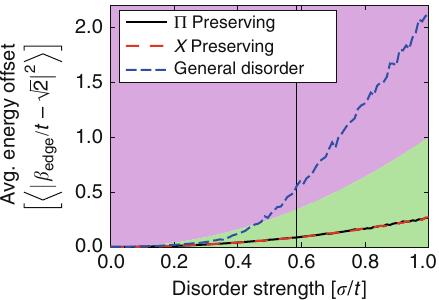
= t (cid:2) ffiffiffi Fig. 2 Disorder analysis. The averaged mean squared difference hj β edge p 2 j 2 i between the boundary state energy β edge in the presence of disorder ffiffiffi p t , as a function of the 2 and the energy of the undisturbed system β 0 ¼ disorder strength σ . Three different disorder types are used, which either do not break one of the symmetries ( χ or Π ) or break both. All three disorder types are chosen such that on average both symmetries, χ and Π , are preserved, i.e., the disorder distribution has a vanishing mean. The vertical solid line indicates the size of the gap between the boundary state and the nearest bulk band. The red and green regions de fi ne an energy offset that is bigger (red) or smaller (green) than ( σ ∕ t ) 2 , which corresponds to the energy scale of the disorder. The disorder-averaging simulations were run using a lattice with 99 sites and every disorder strength σ was realized 10,000 times. Fig. 3 Experimental implementation. a Light dynamics in the three level system of two waveguides and an auxiliary waveguide with carefully chosen refractive index. Since most of the amplitude is in the original waveguides, we can trace out the dynamics of the auxiliary waveguide and obtain a two- level system with an effective negative hopping − t . The horizontal scale bar corresponds to 1 cm, while the vertical scale bar corresponds to 25 μ m. b Placing such a defect within each plaquette of the lattice structure generates a total fl ux of ϕ = π . c An illustration of the quasi-1D array of evanescently coupled waveguides used in the experiment. Light is selectively injected into an input facet of the device and directly imaged using fl uorescence